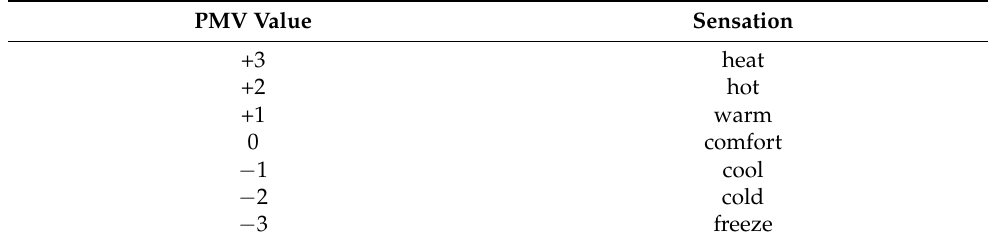
Table 3. Sensation equivalent of PMV value.